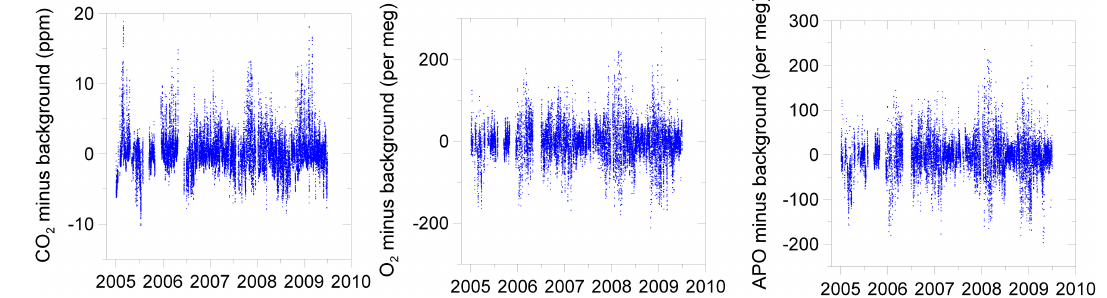
Fig. 5. CO 2 (left), O 2 (center) and APO (right) records after background subtraction.